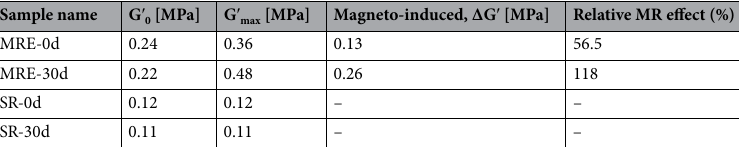
Table 2. The rheological properties of SR and MRE